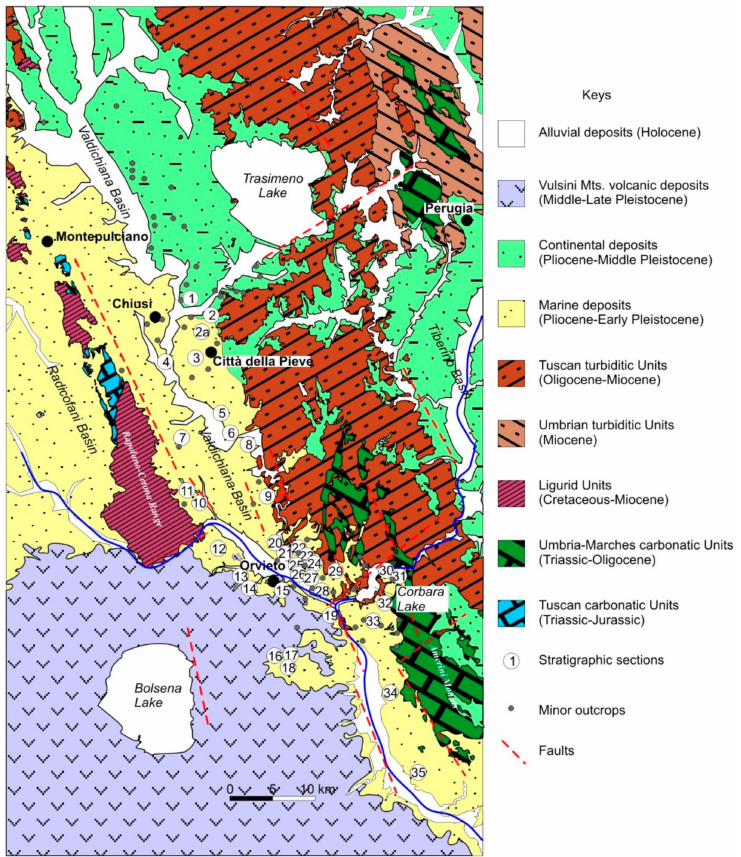
Figure 2. Simplified geological map of the study area. Numbers refer to sections considered in this